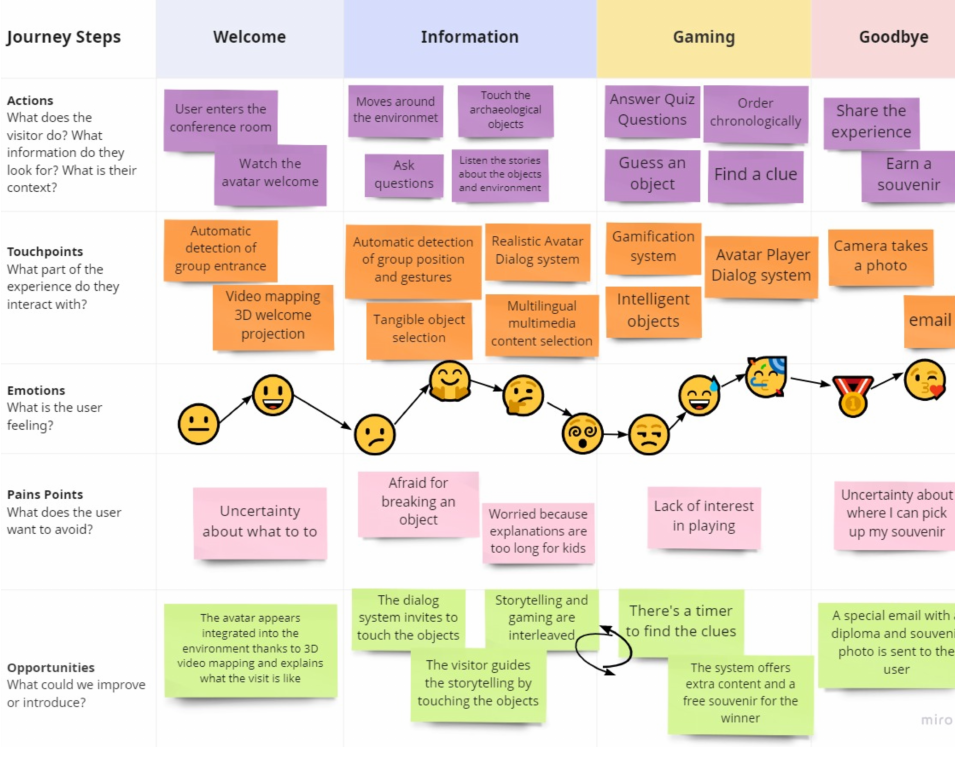
Figure 5. Immersive experience in Roncesvalles: User Journey